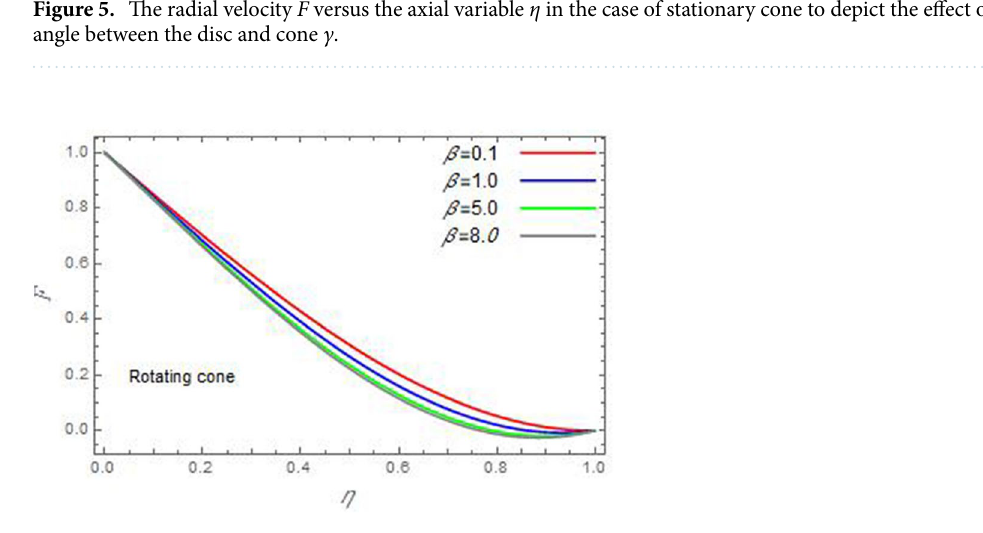
Figure 6. The radial velocity F versus the axial variable η in the case of stationary disc to depict the effect of the material parameter β